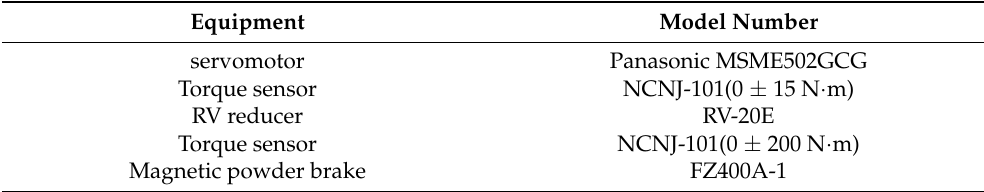
Figure 6. RV reducer test platform. Table 2. Type parameters of RV reducer platform.